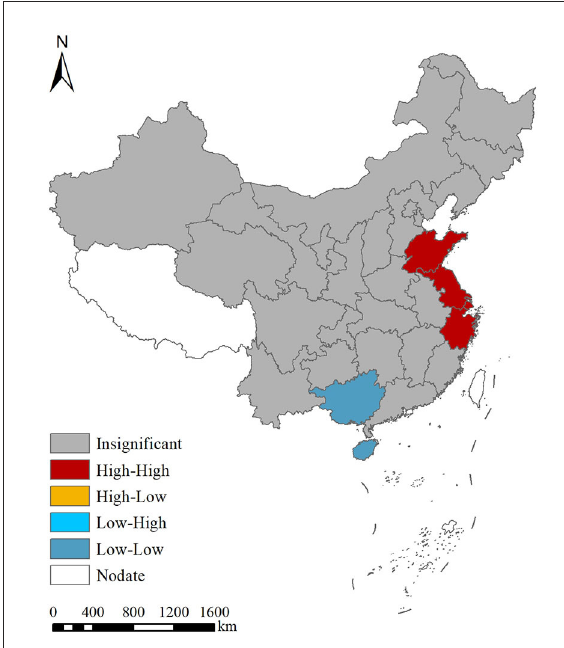
FIGURE3 Hotspot analysis of average annual myopia prevalence in China from 1995 to